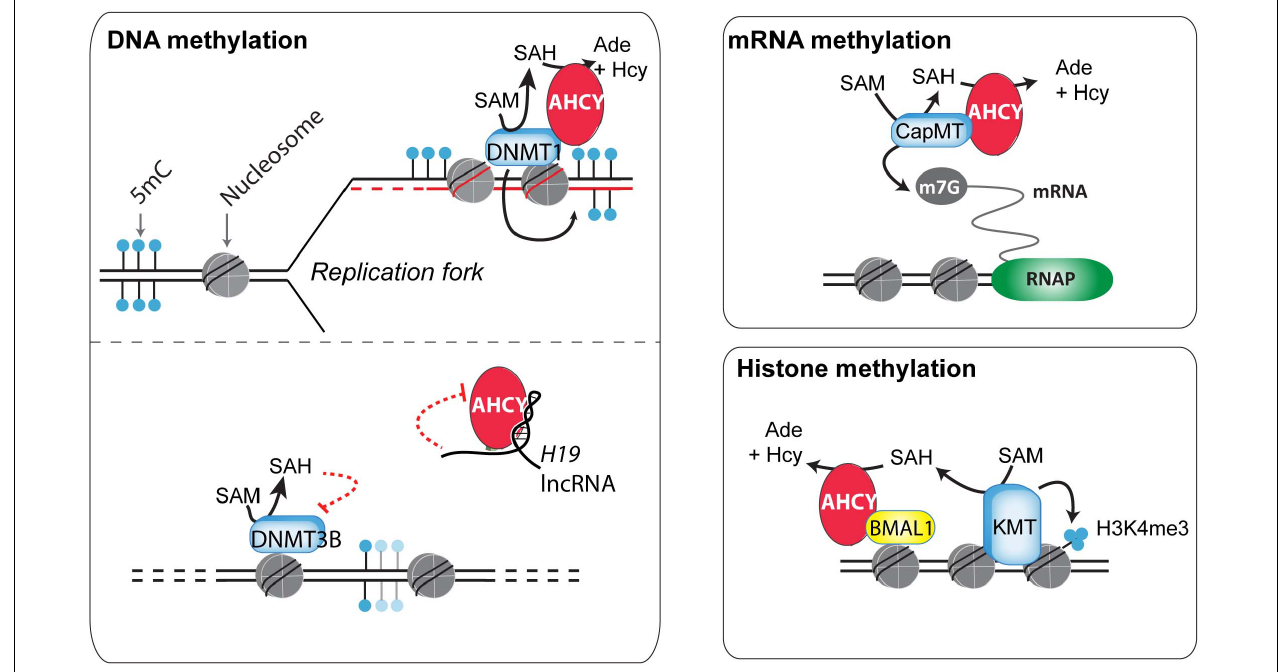
FIGURE 2 | Potential mechanisms of action of AHCY in mammals. Different mechanisms of action have been proposed for the control of DNA, RNA, and histone methylation (discussed in the main